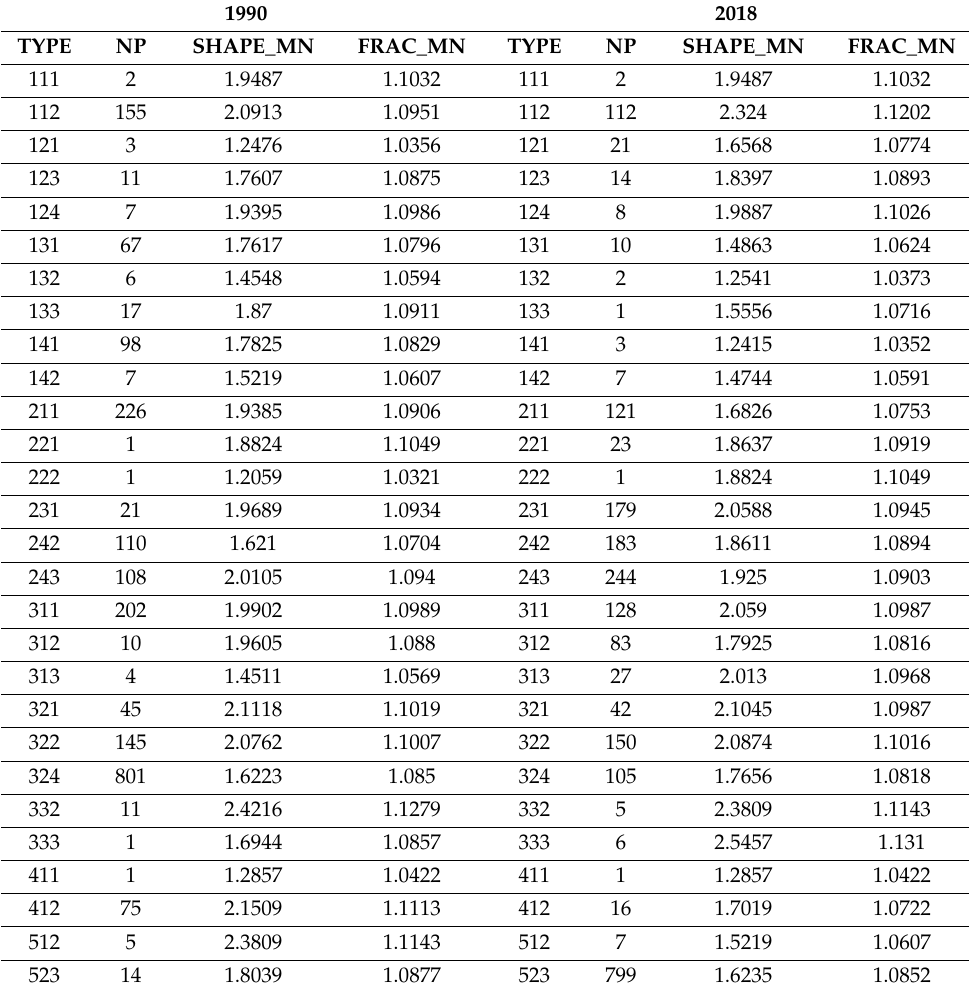
Table 11. Class metrics for the Autonomous Region of